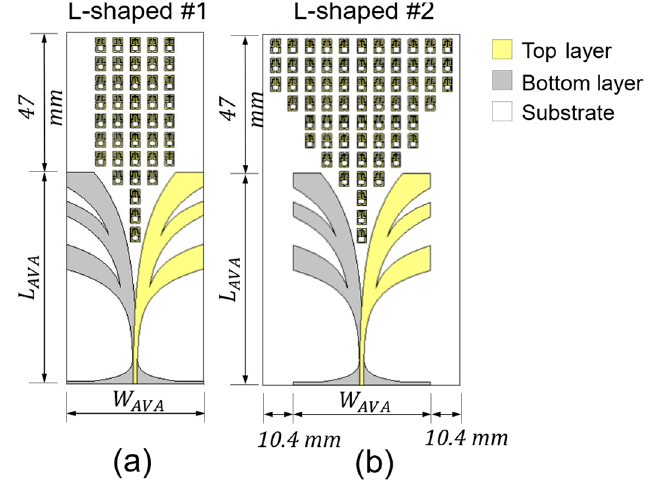
Figure 8. Schematic of AVA with L-shaped metalenses: ( a ) AVA L-shaped#1—array of 41 L-shaped unit cells, and ( b ) AVA L-shaped#2—triangular array of 67 L-shaped unit cells.